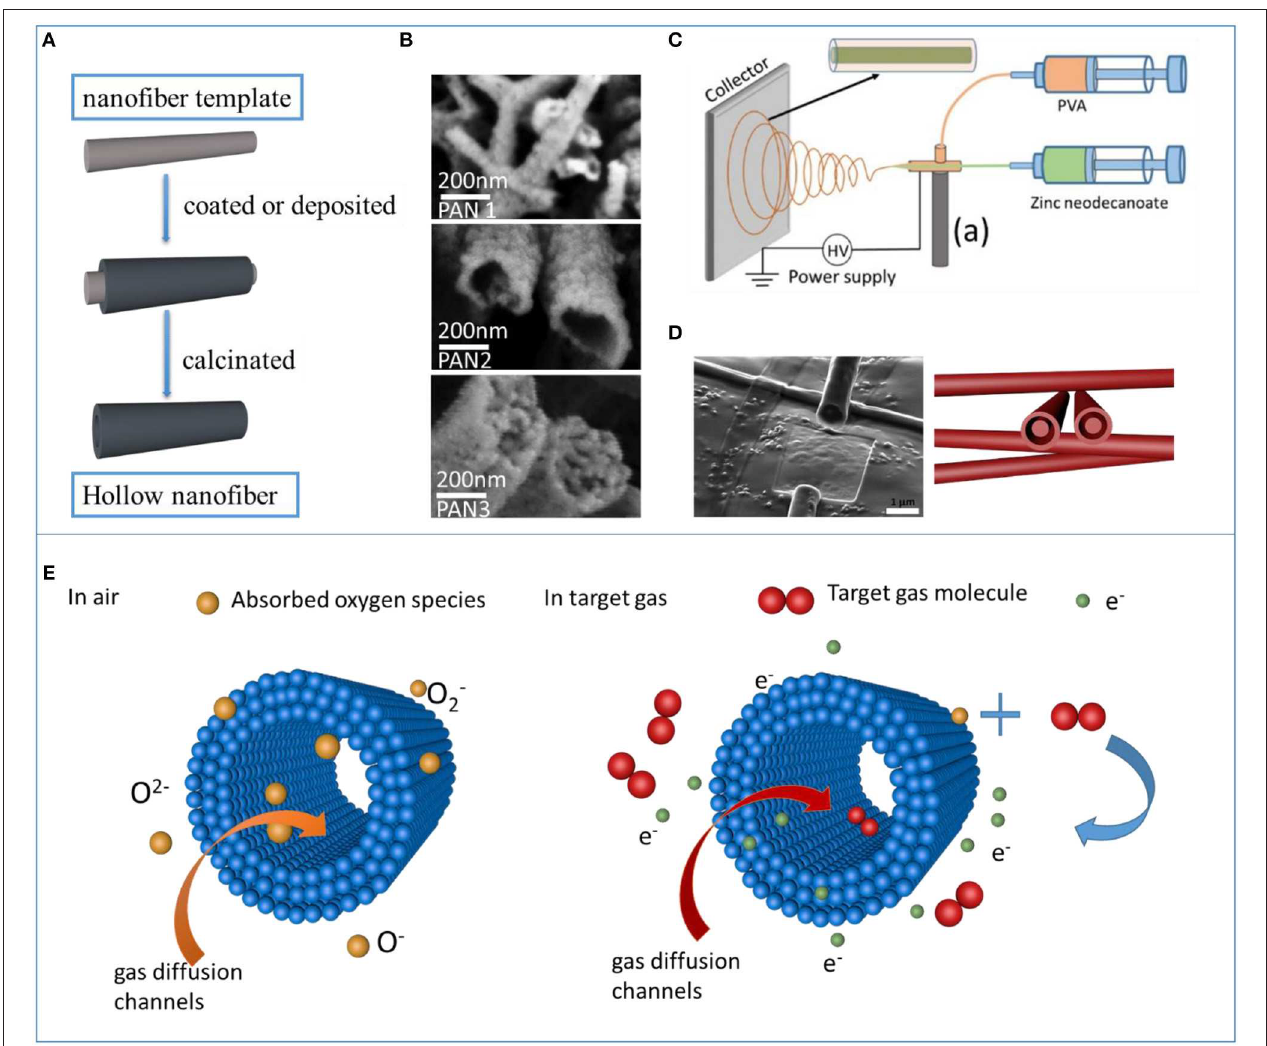
FIGURE 1 | (A) A schematic of template synthesis method. (B) SEM images of the SnO 2 nanofibers electrospun. Reprinted with permission from Ab Kadir et al. (2014) . (C) A schematic of the coaxial electrospinning. Reprinted with permission from Aziz et al. (2018). (D) SEM and 3D structure of coaxial core–sheath structured hollow nanofibers. Reprinted with permission from Liu et al. (2013). (E) Schematic illustration of hollow nanofibers gas